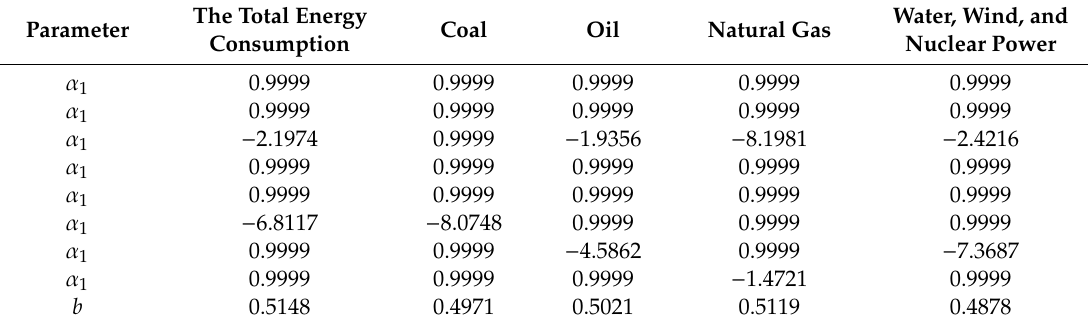
Table 3. Parameter estimation of